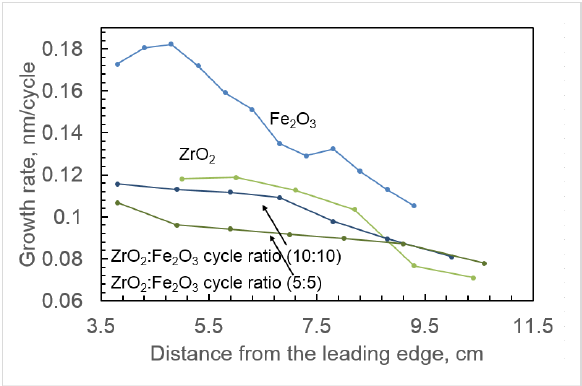
Figure 1: Growth rates of Fe 2 O 3 , ZrO 2 and their mixtures with differ- ent cycle ratios as a function of sample position in the ALD reactor (distance between the sample and valve). All samples of mixed oxides exhibited lower growth rates than pure Fe 2 O 3 or ZrO 2 . Mixtures with cycle ratios not shown in the image exhibited growth rates very similar to the shown mixtures.